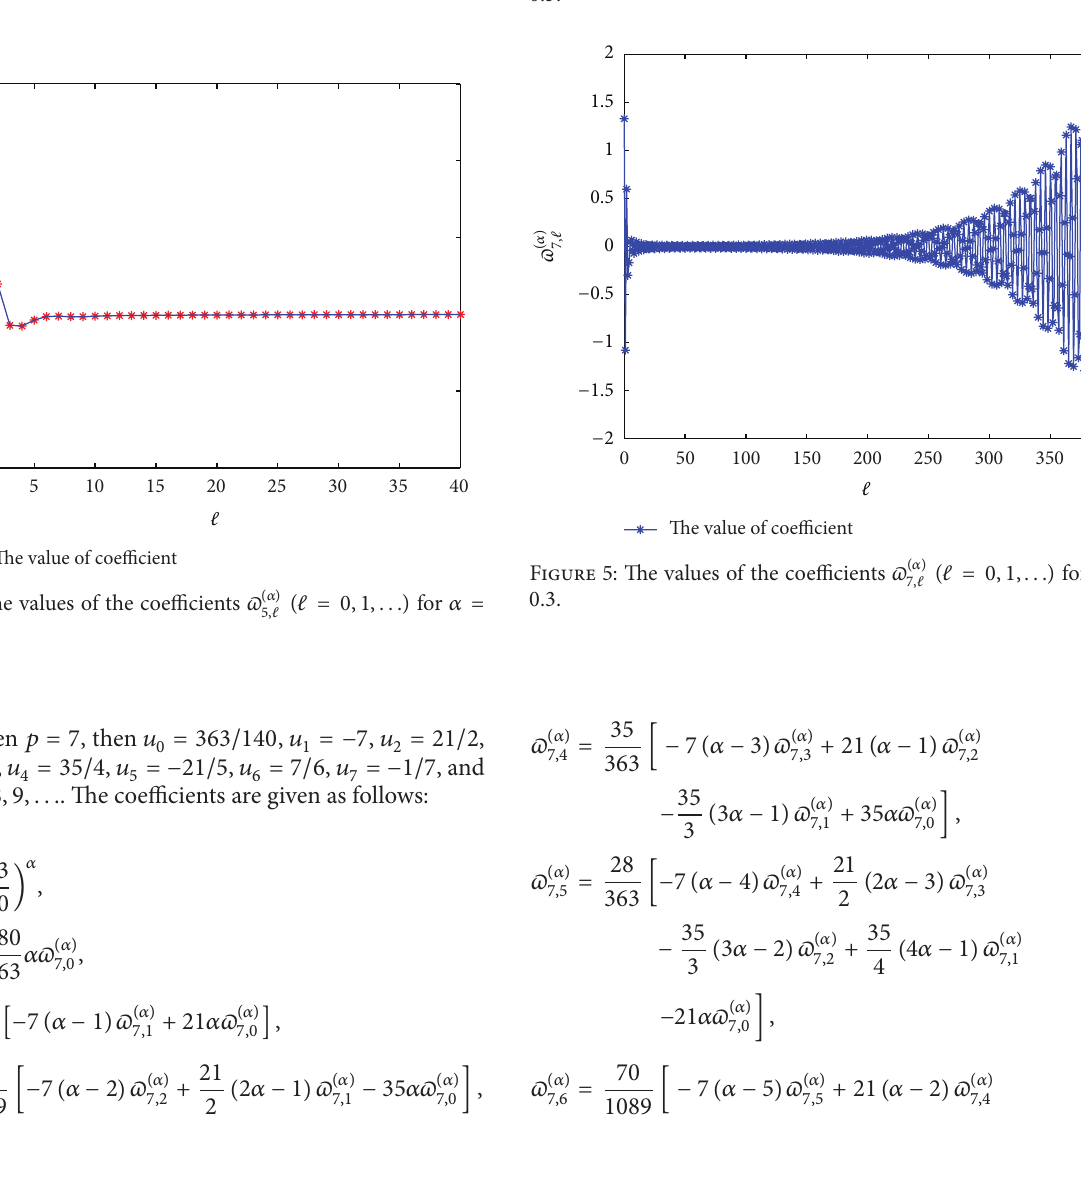
Figure 4: The values of the coefficients 𝜛 (𝛼) 6,ℓ (ℓ = 0,1,...) for 𝛼 = 0.3 .